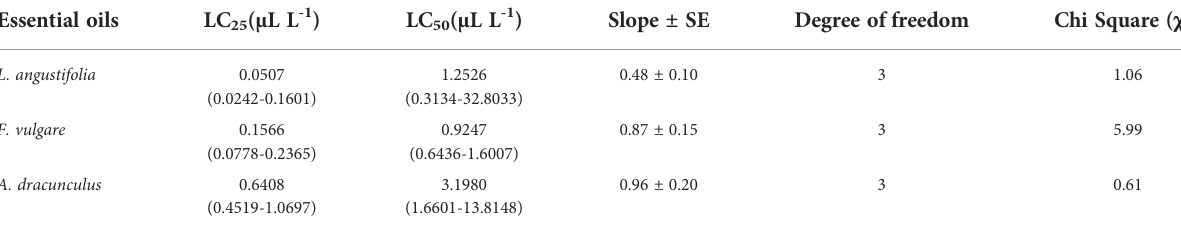
TABLE 1 Fumigant toxicity of essential oils of from L. angustifolia , F. vulgare and A. dracunculus against A. obtectus adults. Essential